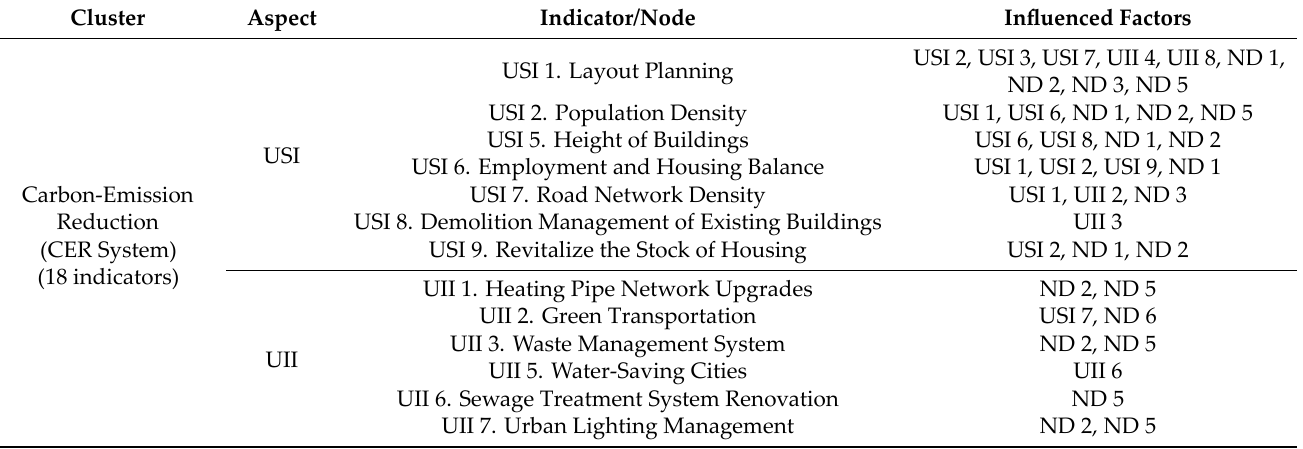
Figure 4. Structure of network for low-carbon urban and neighborhood planning based on the ANP (detail correlations between clusters and indicators refer to Table 4). Table 4. Division of the indicators into two clusters, and the correlations between the indicators.